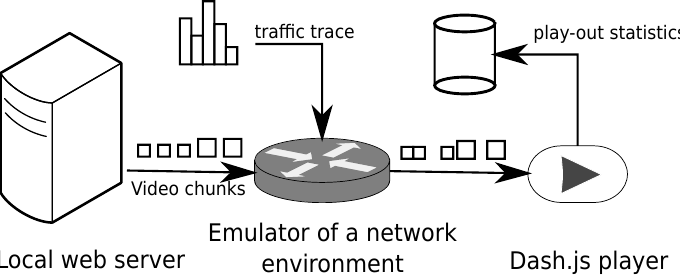
Figure 10. Experiment setup includes a web server, the netem module and the dash.js video player. The connection between the emulated network and the server has fixed parameters. The netem module shapes the traffic between the emulated network and the DASH player, providing variable transmission time of video segments.